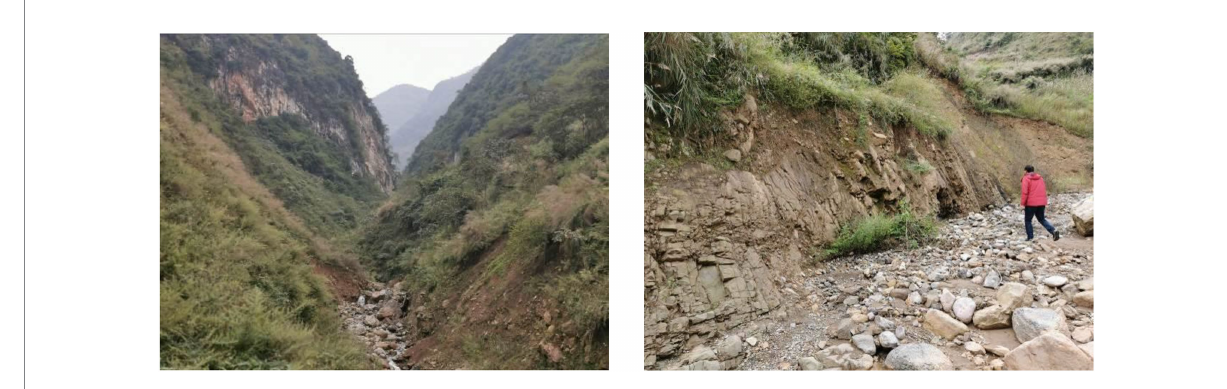
FIGURE 10 Photos of loose solid materials in Legugou watershed.